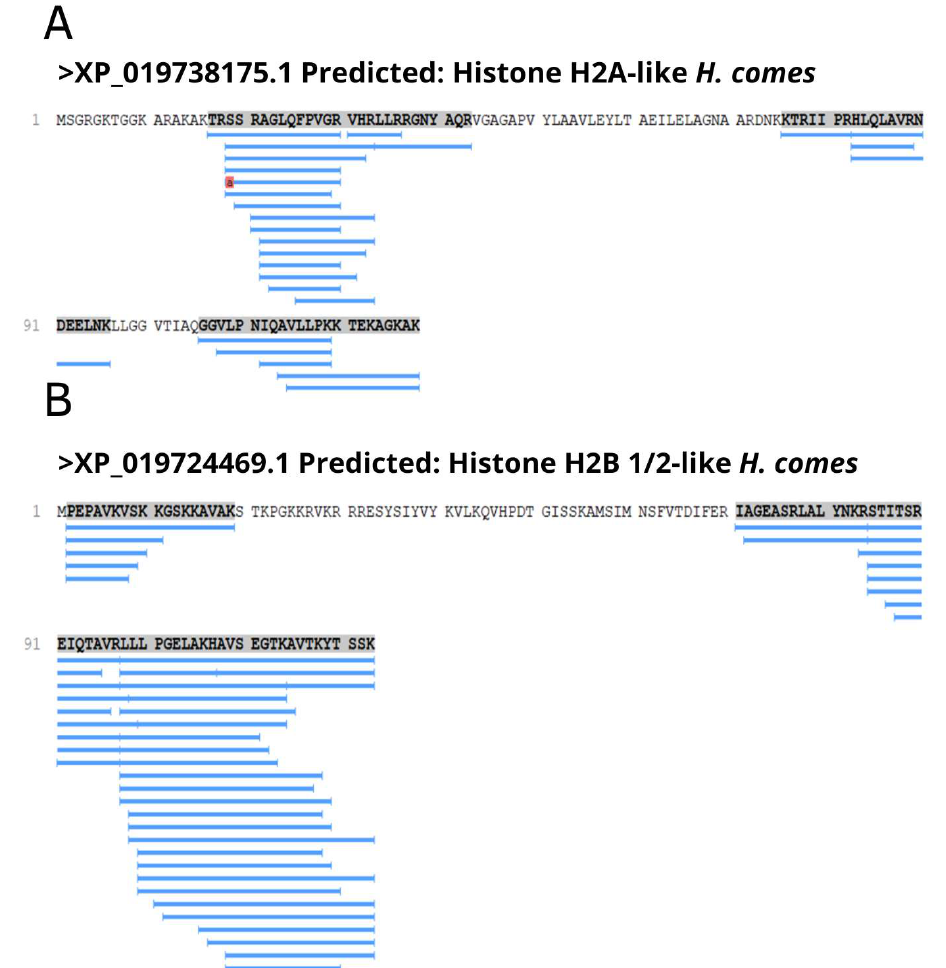
Figure 6. Histone-like derived peptides identified in gills of H. reidi. Location of peptide fragments (underlined in blue) in the amino acid sequence of the predicted histone H2A-like ( A ) and histone H2B-like protein ( B ).